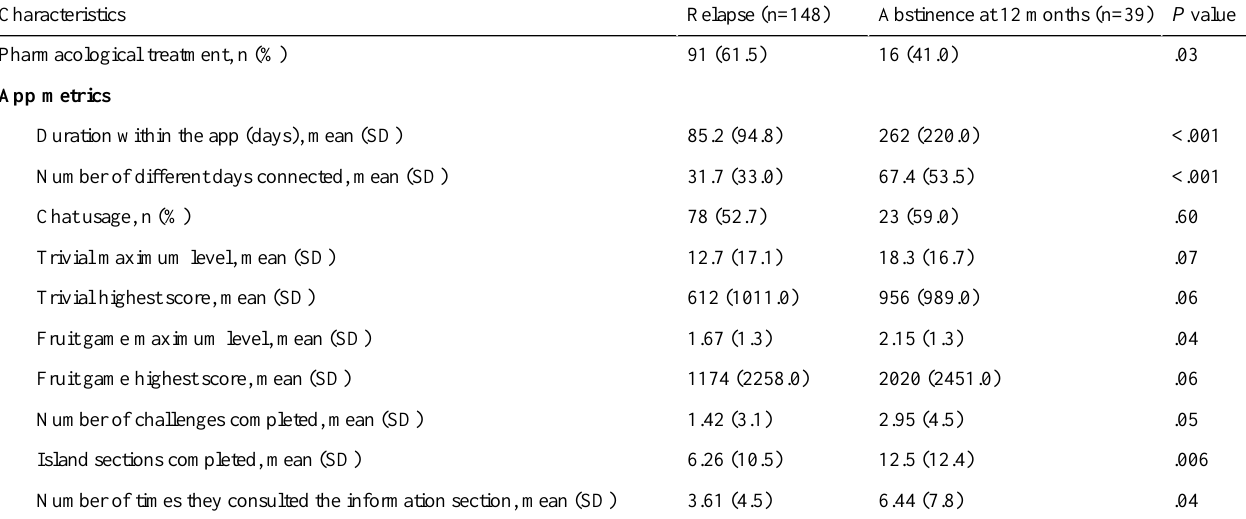
Table 2. List of a set of app metrics, classified according to the success rate at the end of the study (12 months from the day at which they stopped smoking) for participants of the intervention group who used the app